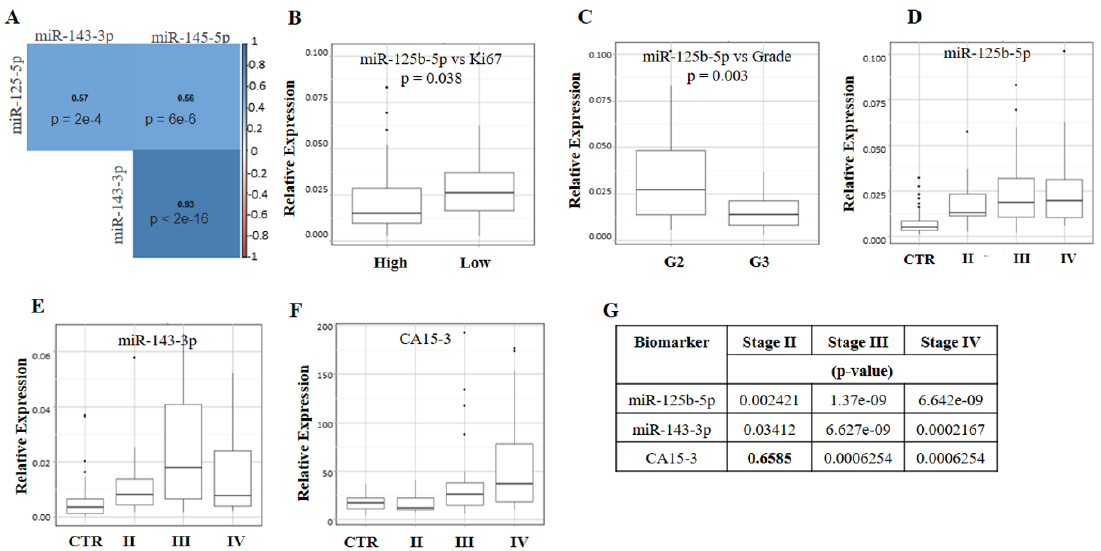
Figure 4. Correlation studies. Co-expression analyses of miR-125b-5p, miR-143-3p and miR-145-5p ( A ). Expression levels of miR-125b-5p vs. Ki67 (low < 20%; high ≥ 20%) ( B ), and grade ( C ). Expression levels of miR-125b-5p ( D ), miR-143-3p ( E ), and CA15-3 ( F ) vs. stage. Statistical significance ( G ). Non-significant results are reported in bold.